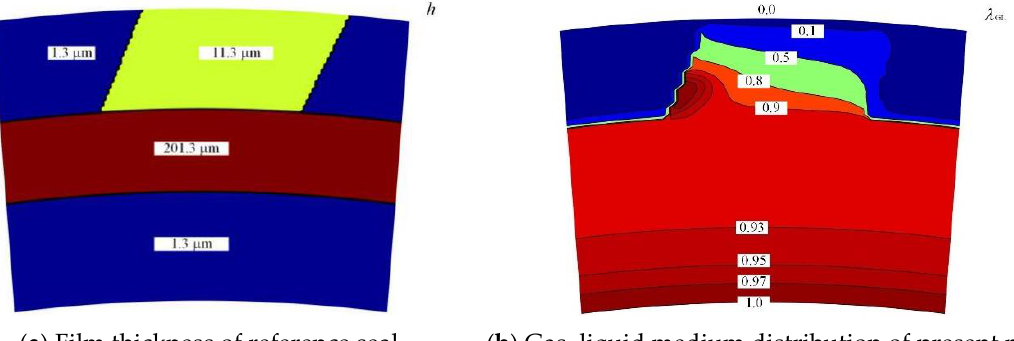
Figure 3. Numerical results of reference seal obtained using present model: ( a ) distribution of film thickness of reference model [22] and ( b ) gas – liquid medium distribution of present model. ( ω = 7000 rpm, p o = 0.101 MPa, p i = 0.102 MPa and h 0 = 1.3 μm).